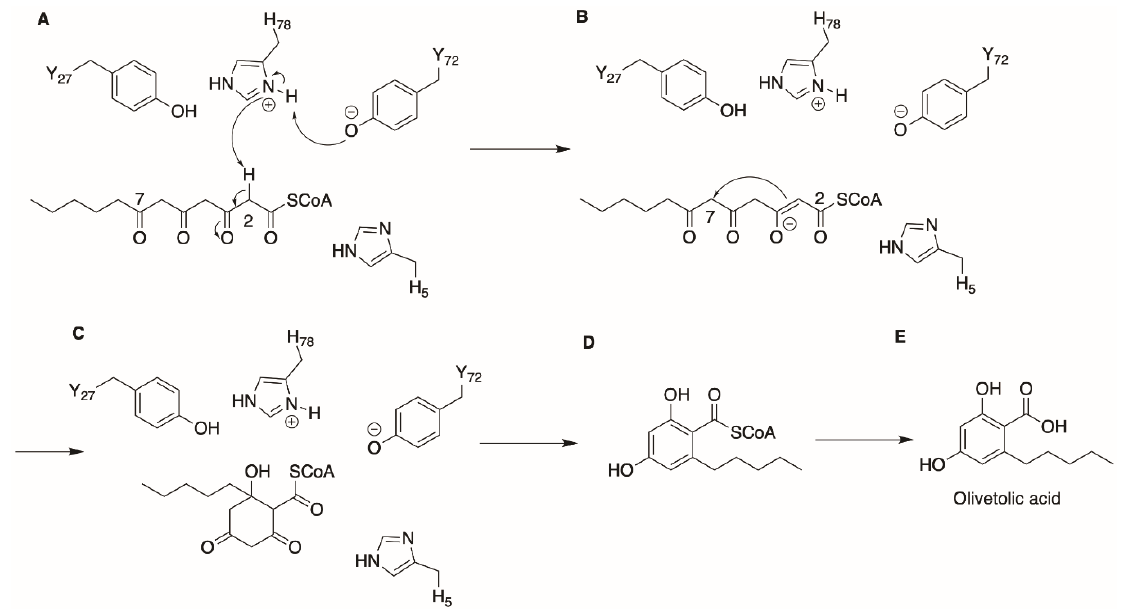
Figure 4. Proposed OAC cyclization mechanism to form OLA. ( A ) Extraction of proton by His78 from C2 of substrate. ( B , C ) C2 to C7 aldol condensation facilitated by reabsorption of proton from His78 by carbonyl O on C7. ( D , E ) Aromatization, release of CoA thioester and subsequent release of OLA product.